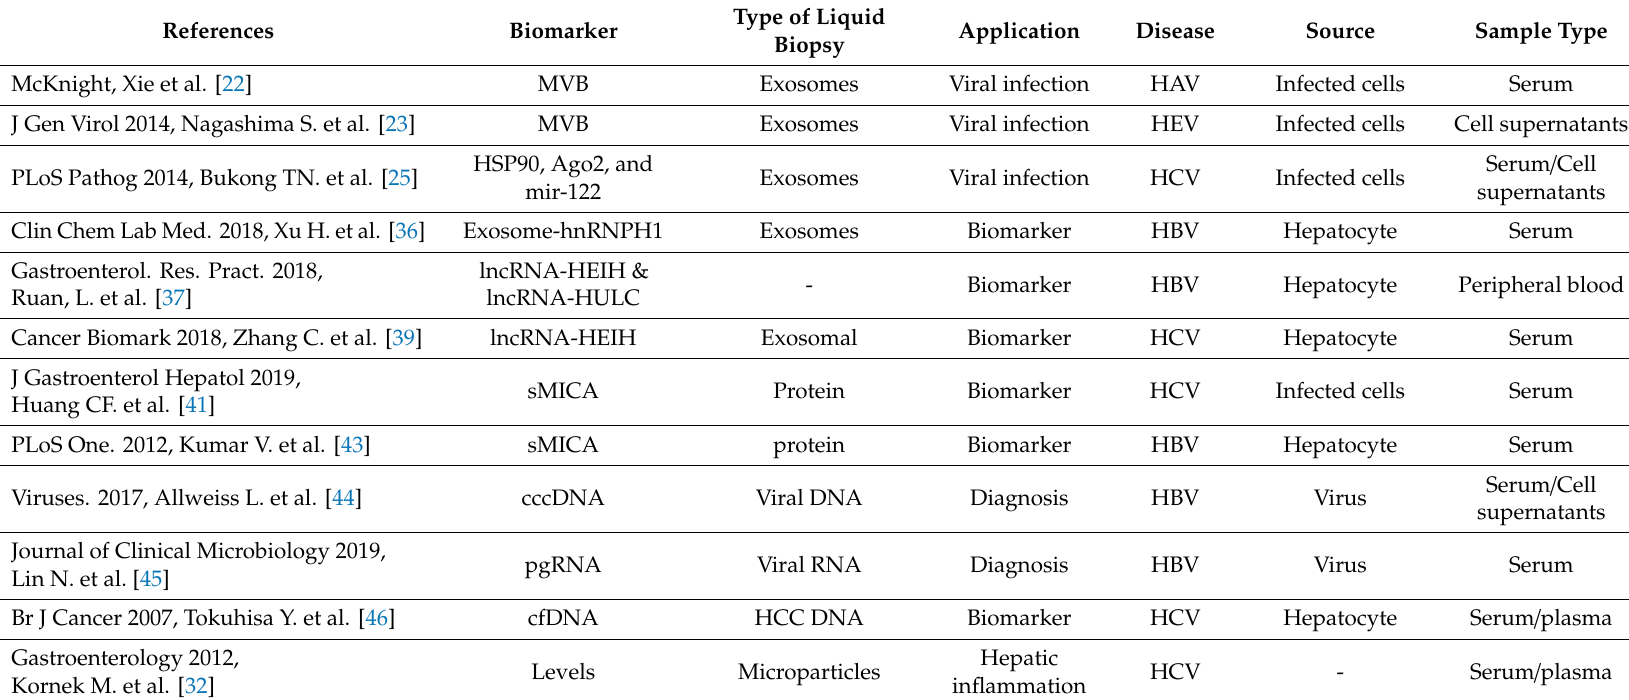
Table 1. Liquid biomarkers of viral hepatitis liver